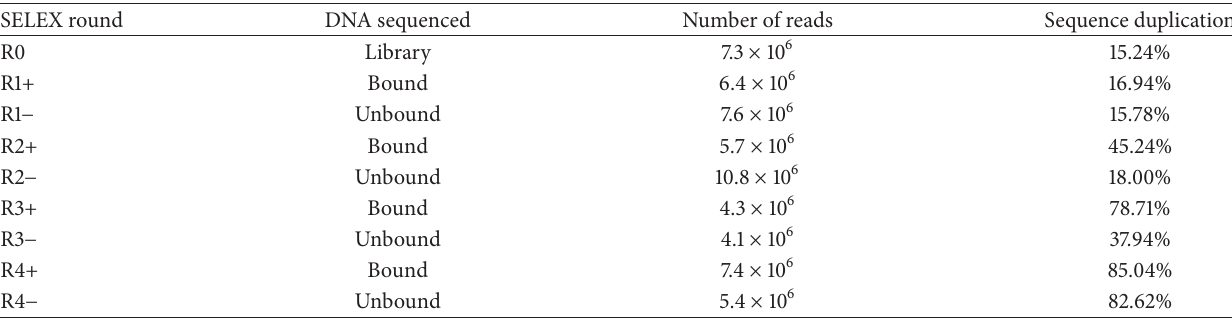
Table 1: Characteristics of data resulting from Illumina sequencing. R0 is the unselected random DNA library; other numbers designate the SELEX round and whether the DNA was bound to CA125 (+) or was not bound ( − ).